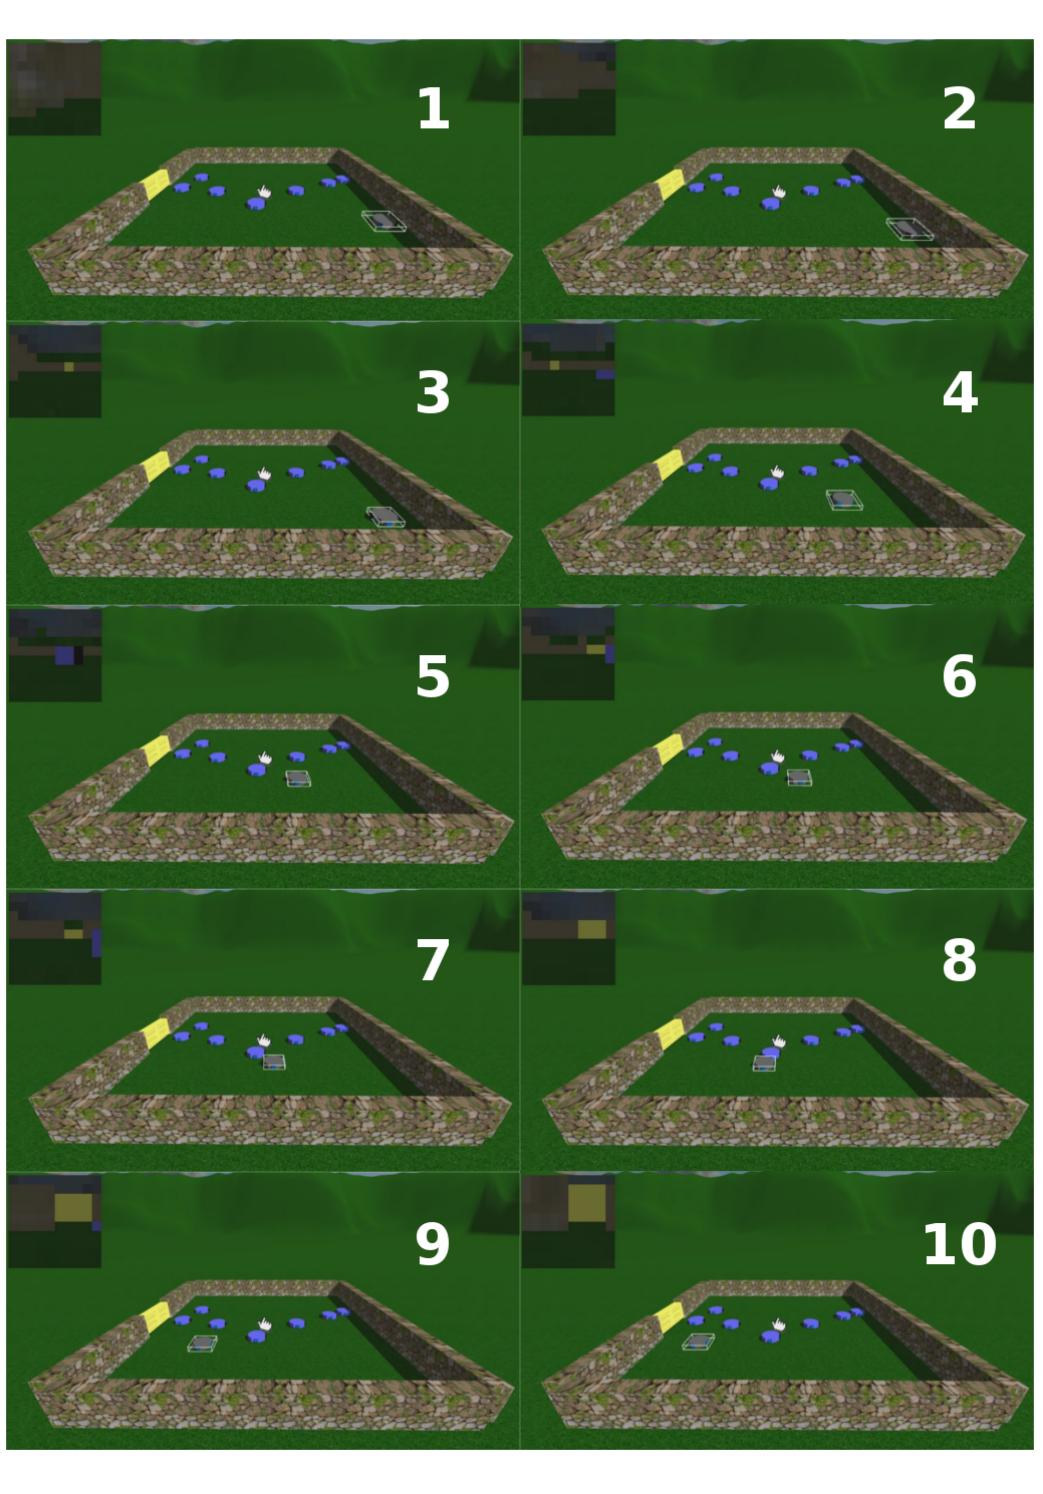
Fig. 5. Locomotion of one agent guided by its own vision. In the top left part of each picture we can see the visual field of the selected